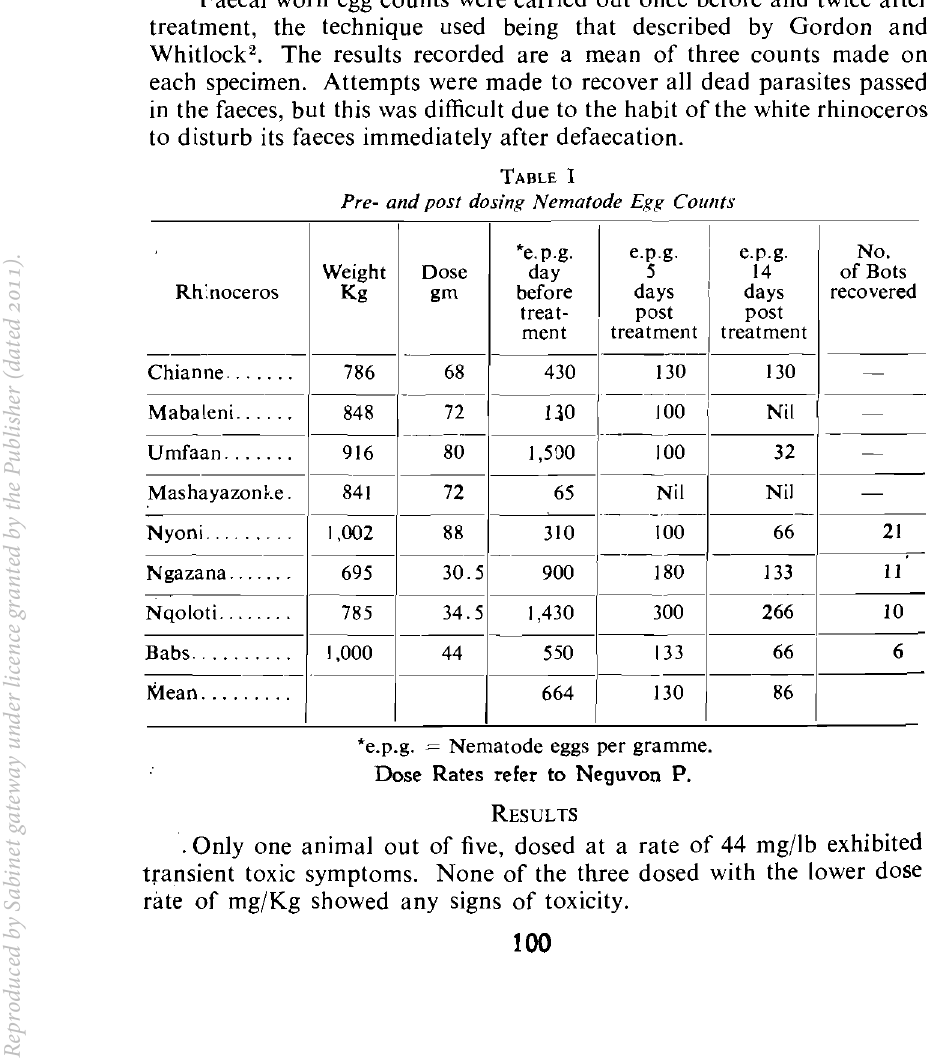
TABLE I Pre- and post dosing Nematode Egg